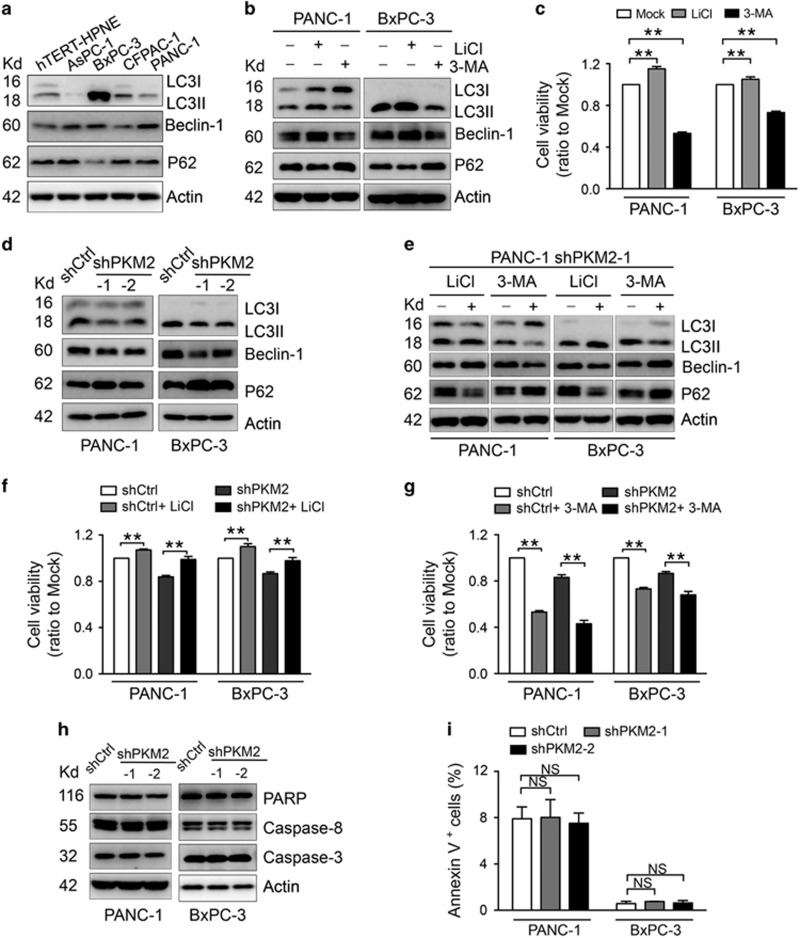
PKM2 silencing impairs pancreatic cancer growth by inhibiting autophagy rather than by inducing apoptosis. (a) Western blot detection of the LC3-I/II ratio, Beclin-1 and p62 in pancreatic cancer cells and normal hTERT-HPNE cells. (b) Western blot analysis of the LC3-I/II ratio, Beclin-1 and p62 expression in cells treated with either LiCl (1 mM) or 3-MA (5 mM) for 2 days. (c) The viability of cells treated with either LiCl (1 mM) or 3-MA (5 mM) for 2 days as measured by the CCK-8 assay. (d) Autophagy marker proteins were detected in PANC-1 and BxPC-3 cells stably transduced with shPKM2. (e) Autophagy marker proteins were detected in PANC-1 and BxPC-3 cells stably transduced with shPKM2 and treated with either LiCl (1 mM) or 3-MA (5 mM) for 2 days. (f and g) The viability of cells with PKM2 knockdown after treatment with either LiCl (1 mM; f) or 3-MA (5 mM; g) for 2 days. (h) Western blot detection of caspase-8, caspase-3 and PARP in PANC-1 and BxPC-3 cells stably transduced with shPKM2. (i) Apoptosis was evaluated in cells with stable knockdown of PKM2 using annexin V/PI staining. NS, no significance. Actin was used as a loading control in a, b, d, e and h). The cell viability in c, f and g was shown as the fold change relative to untreated mock cells. All experiments were repeated three times, and the bars represent the mean±S.D. (n=3). *P<0.05, **P<0.01